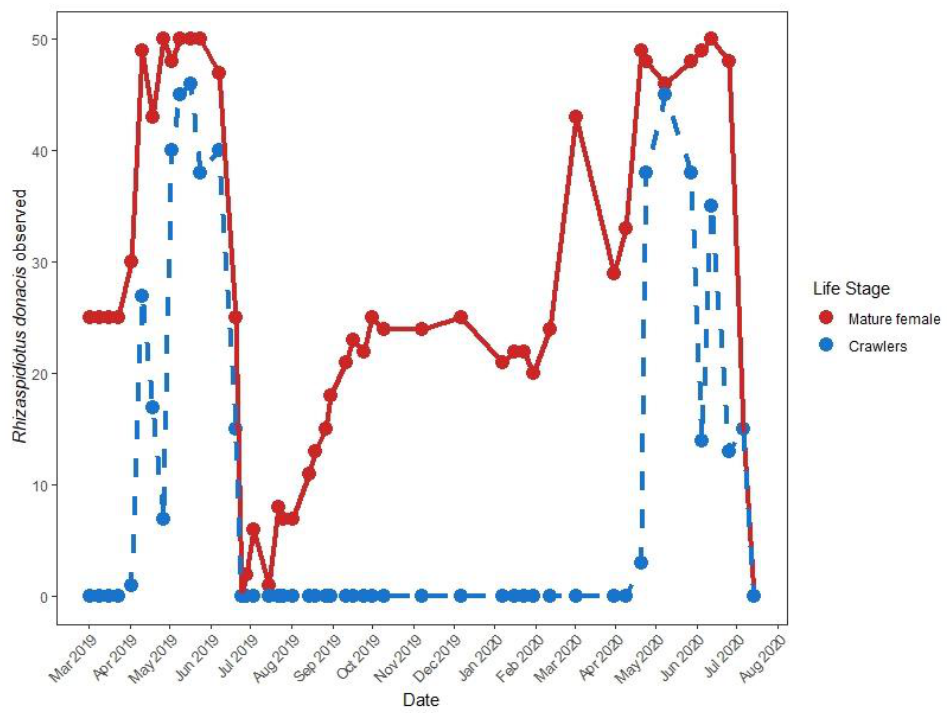
Figure 6. Adventive southern California Rhizaspidiotus donacis adult and crawler seasonality of life stages. Each sample point shows how many of 50 encountered R. donacis were mature females (red solid line) and how many females had crawlers present internally or within the scale test (blue dashed line).